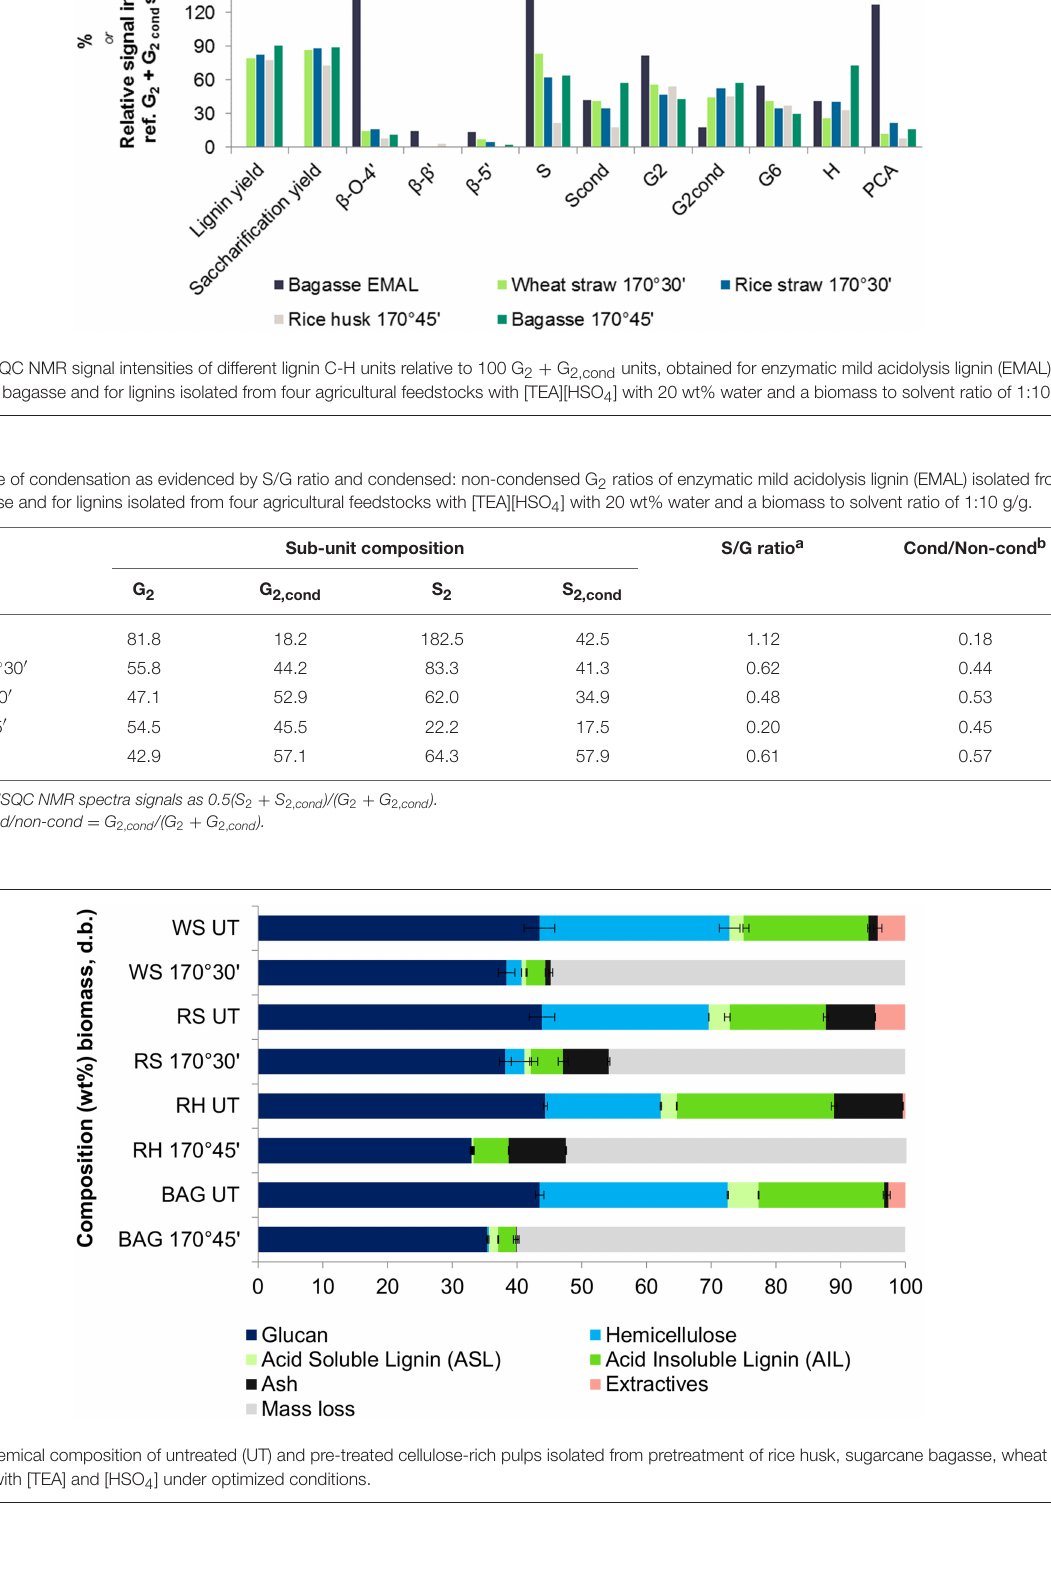
Frontiers in Chemistry |